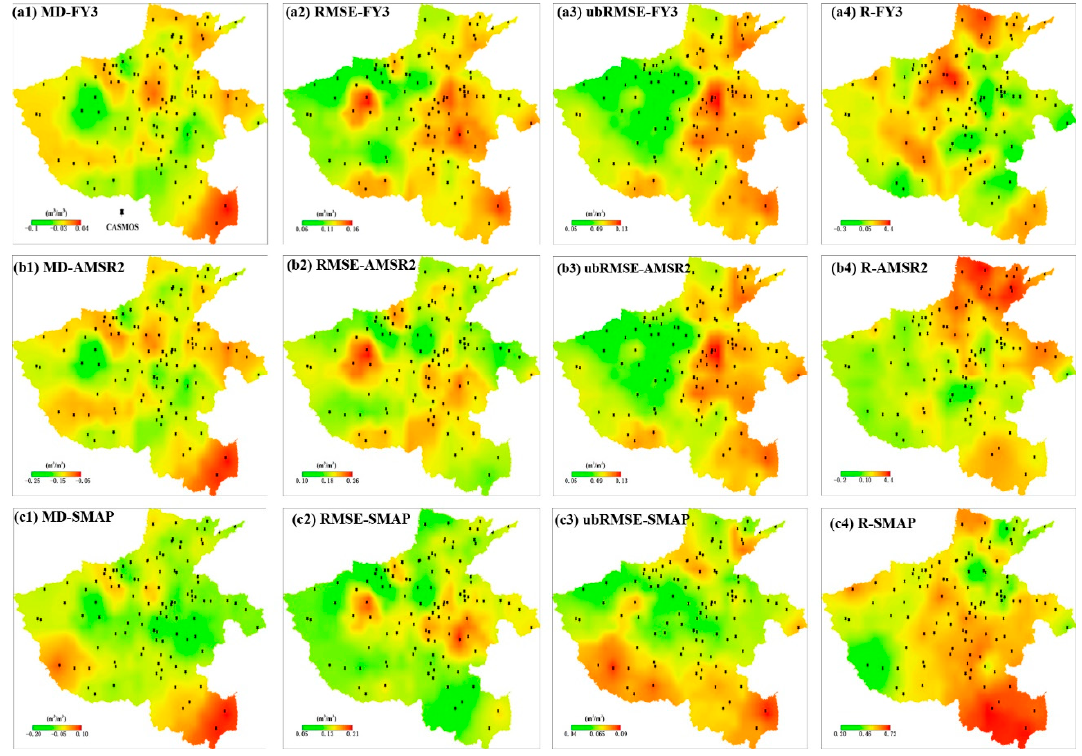
Figure 7. The spatial distribution difference between the FY-3C, AMSR2, and SMAP retrievals against in-situ measurements for the period of 1 January 2016 to 31 December 2016: ( a ) FY-3C, ( b ) AMSR2, and ( c ) SMAP. The black thumbtacks represent the 113 CASMOS stations used for the spatial interpolation. The interpolations were performed using the inverse distance weighted (IDW) method in ArcGIS, with the outsize as 0.25, the power as 1, and the search radius as 4 points.